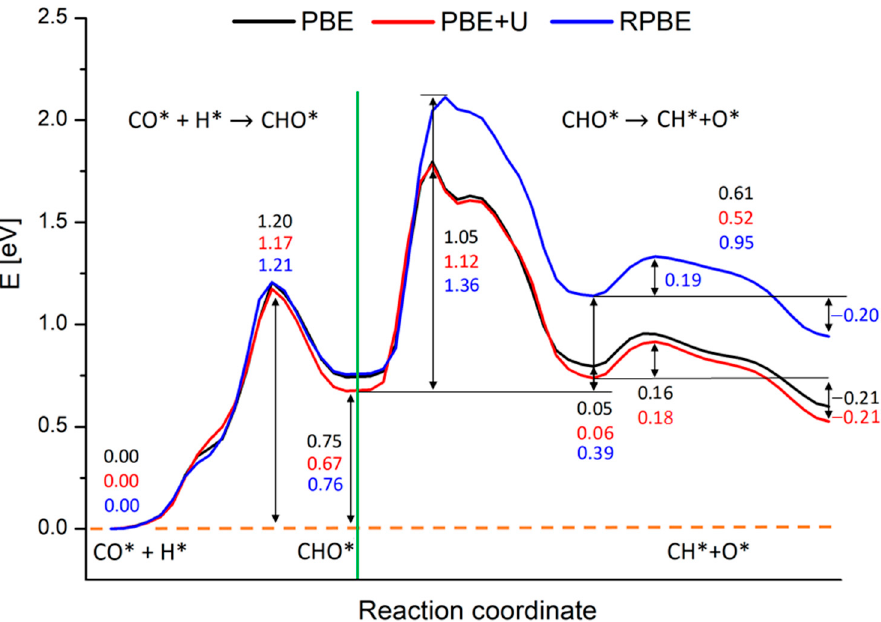
Figure 5. Reaction energy profiles for the whole CO* + H* → CH* + O* reaction on Rh (100) surface, involving CHO*. Black, red and blue lines represent the profiles calculated at the PBE, PBE+U and RPBE levels respectively. The numbers report the values of energy barriers and reaction energies in eV. The green line separates the two subprocesses in which we split the calculations: the CHO* generation starting from CO* and H and the CHO* dissociation in CH* and O*.